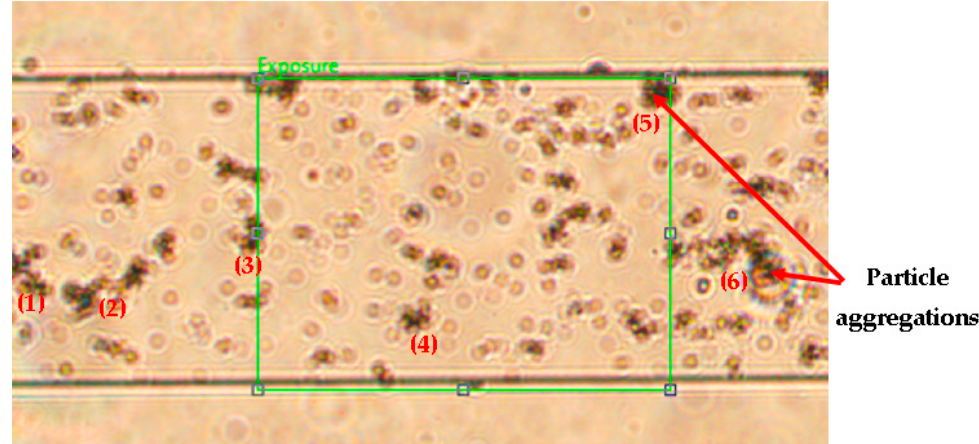
Figure 15. Microscope image of cobalt ferrite particles suspended in water in the PDMS single microchannel device. The numbered regions show the locations of the largest particle aggregations. The blurry particles represent particles closer to the bottom of the channel.